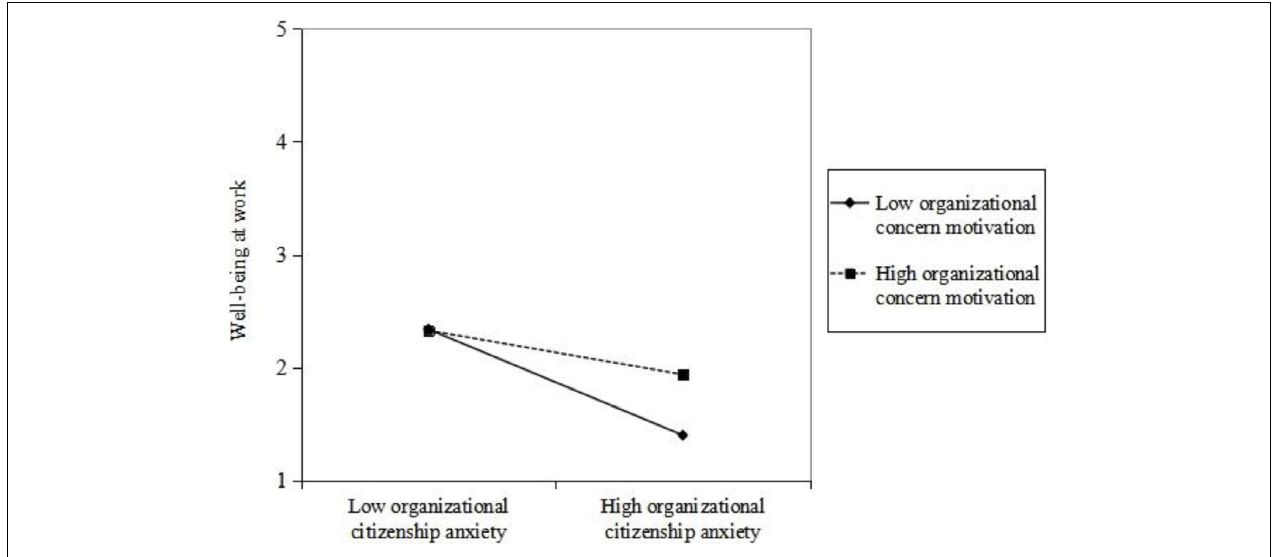
FIGURE 2 | The moderating effect of organizational concern